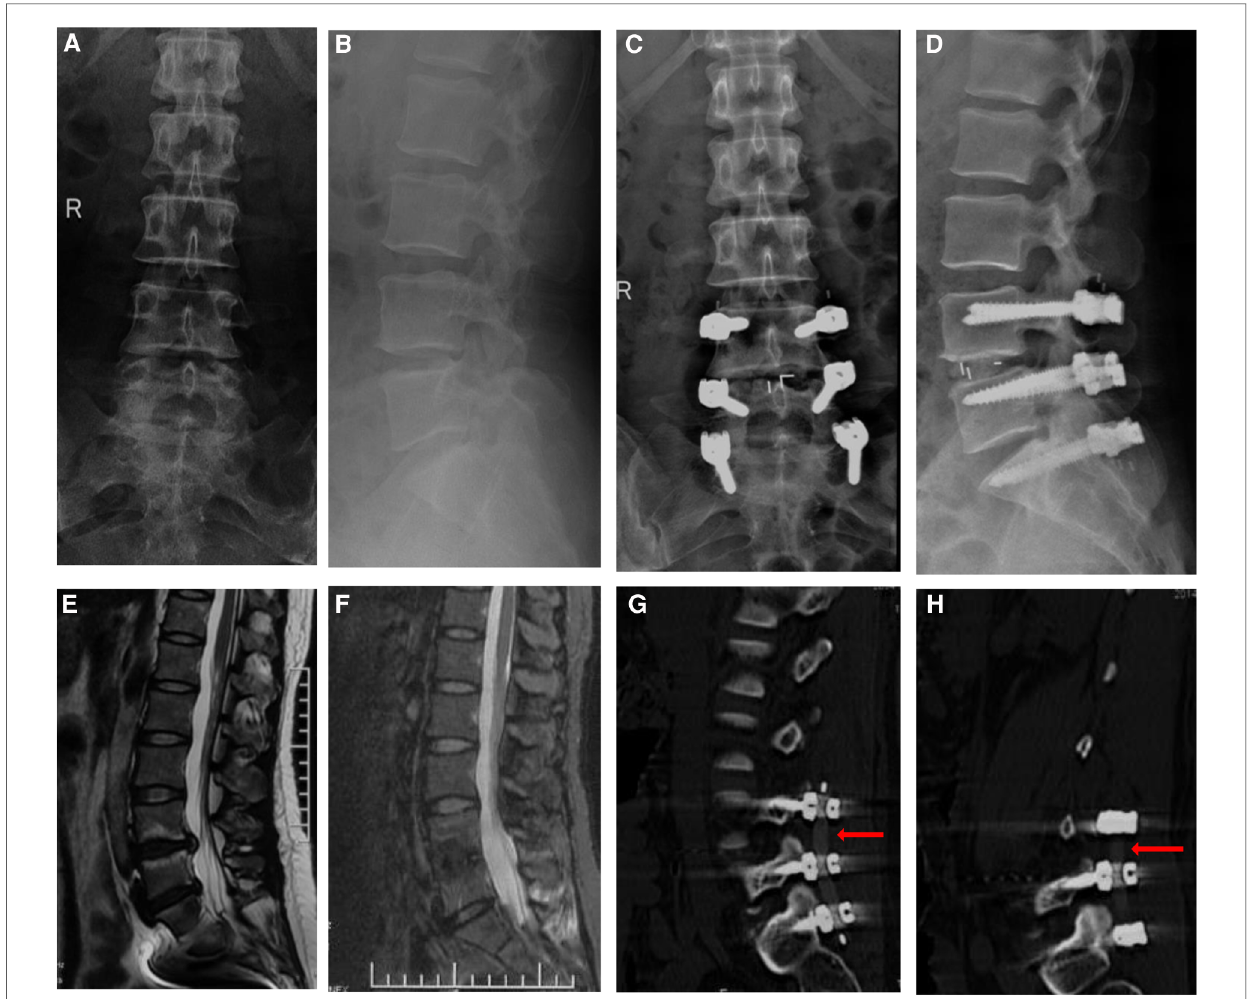
FIGURE 3 A 45 years female patient diagnosed with lumbar spinal stenosis underwent posterior PEEK rods hybrid surgery with fusion procedure at the L4/5 level and non-fusion procedure at the L5/S1 level. Preoperative anterior-posterior and lateral fl uoroscopy was showed in ( A , B ), while postoperative anterior- posterior and lateral fl uoroscopy at the fi nal follow-up was showed in ( C , D ). Compared preoperative sagittal MRI scans ( E ) with sagittal MRI scans at the fi nal follow-up ( F ), it was found that intervertebral disc degeneration improved from Grade 4 to Grade 3 according to P fi rrmann Classi fi cation. The CT reconstruction con fi rmed that the bilateral PEEK rods were intact at the fi nal follow-up ( G , H